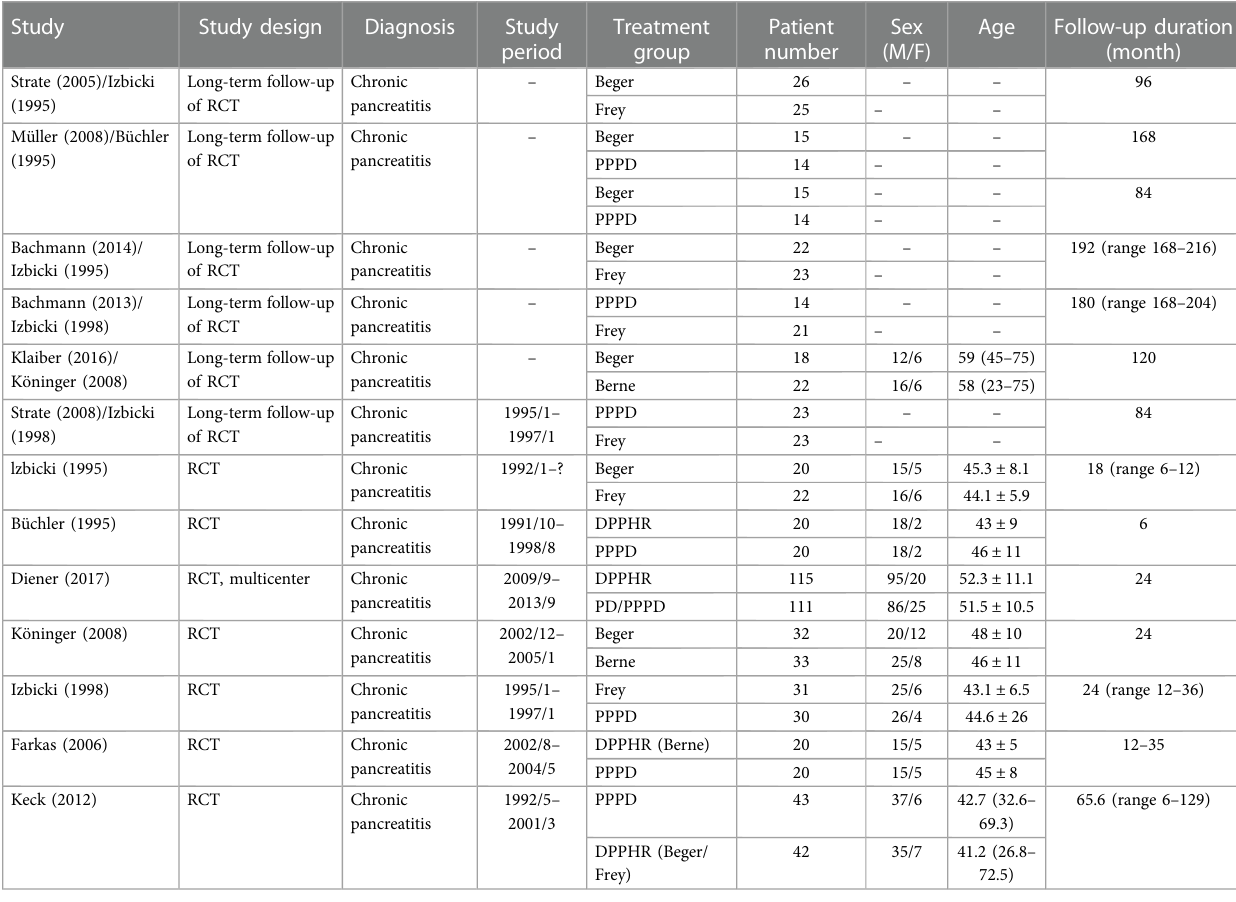
TABLE 2 Characteristics of the enrolled randomized studies.